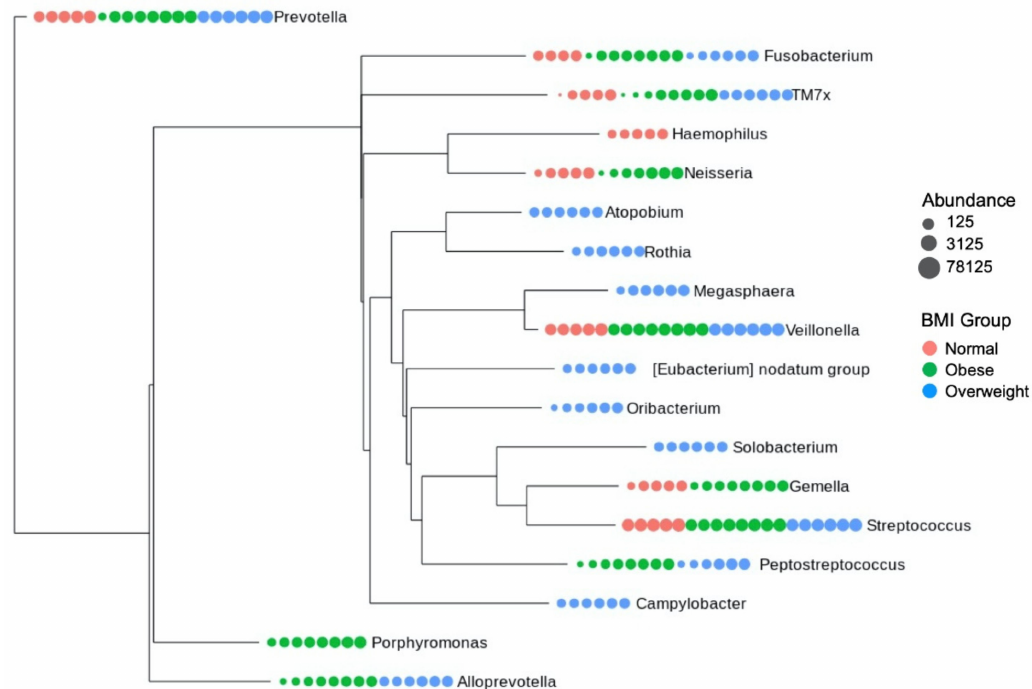
Figure 4. Dendrogram showing the distribution and phylogenetic relationship of the identified core microbial